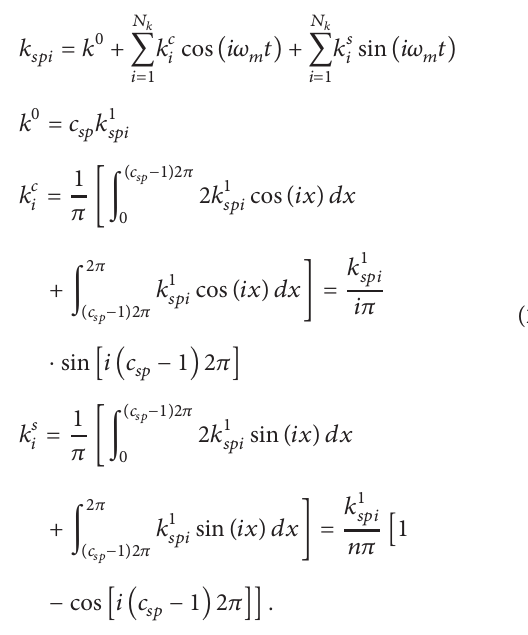
Table 1: Parameters of PGT.